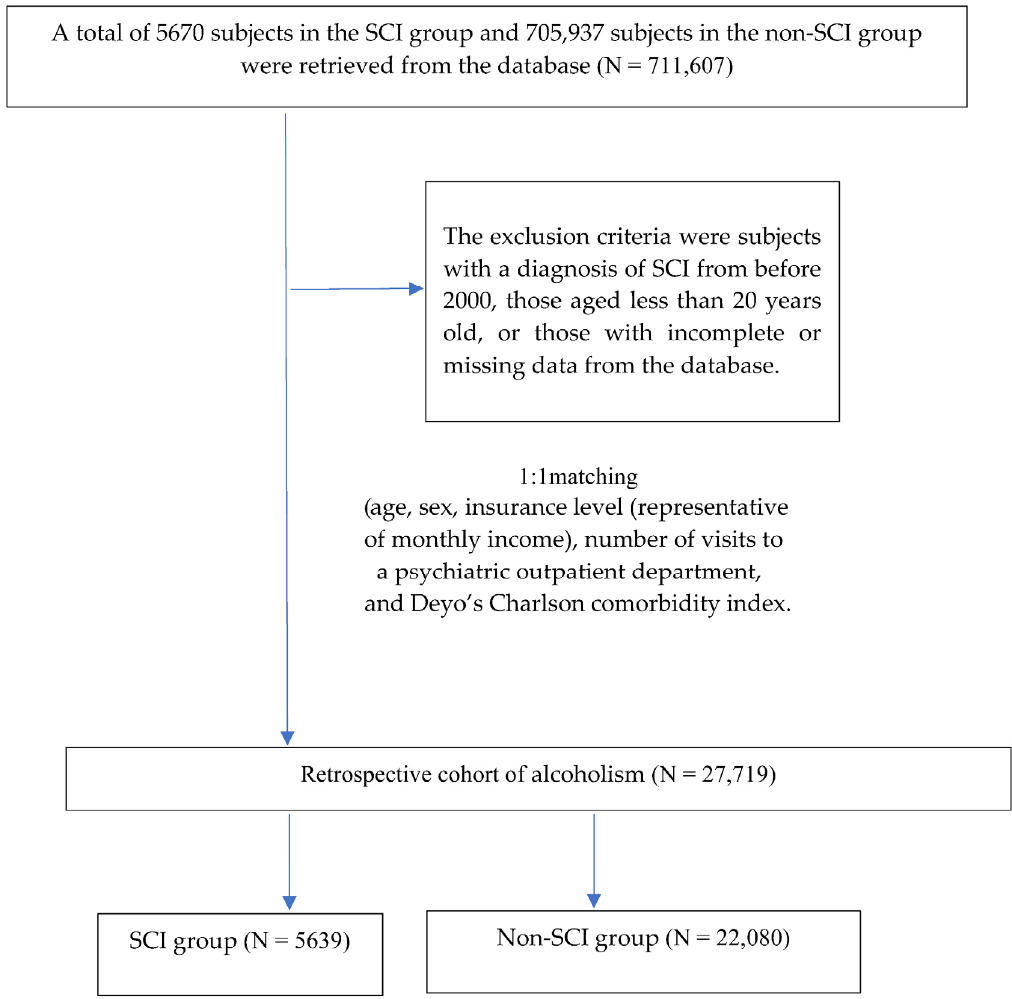
Figure 1. The sample selection of alcohol dependence.